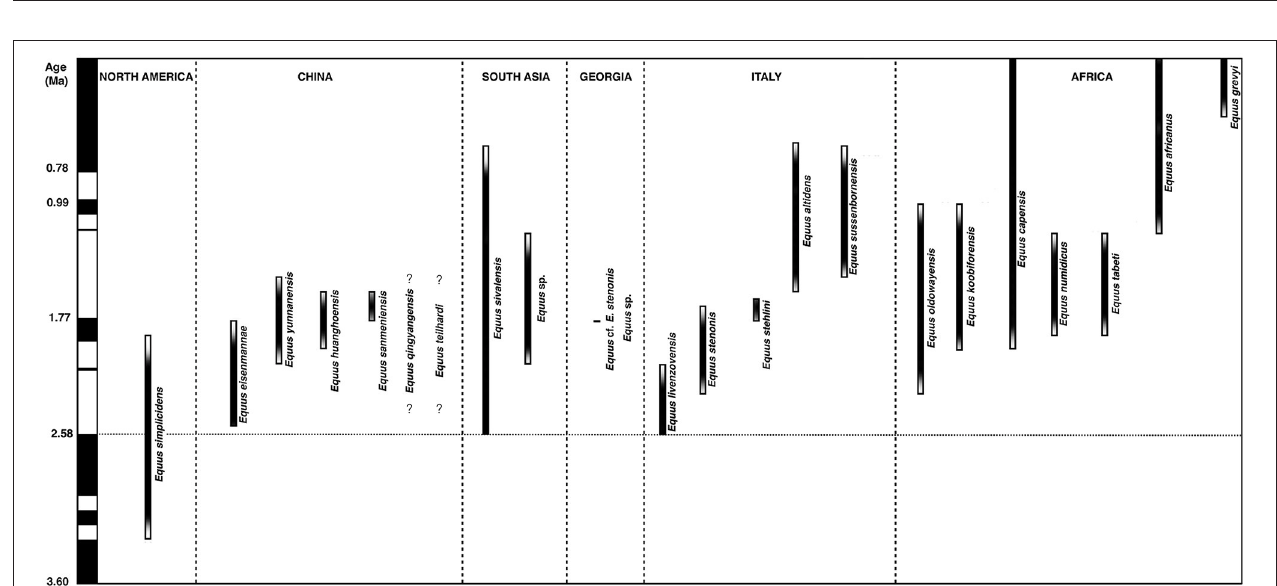
FIGURE 2 | Chronology of the taxa in North America, Asia, South Asia, Georgia, Italy, and Africa.